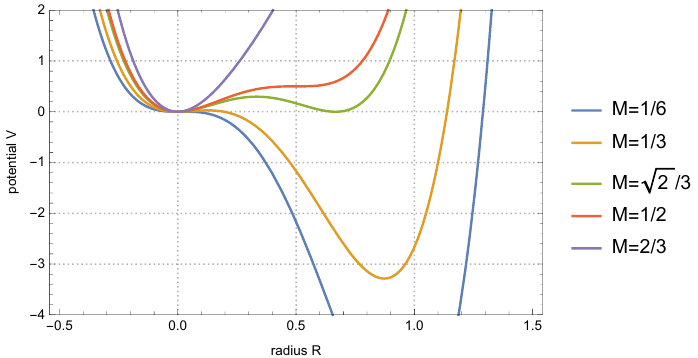
Figure 24. Potential for equal masses M = M i and equal radii R = R i